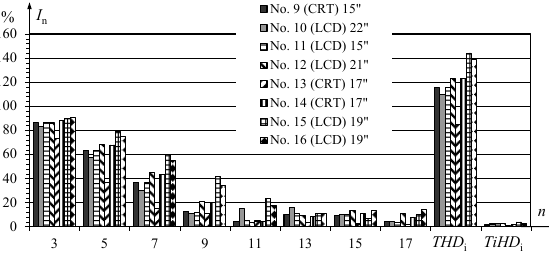
Fig.3. Percentage of higher current harmonics and THD I and TiHD I drawn from a low-voltage power grid by monitors during operation. Part 2.